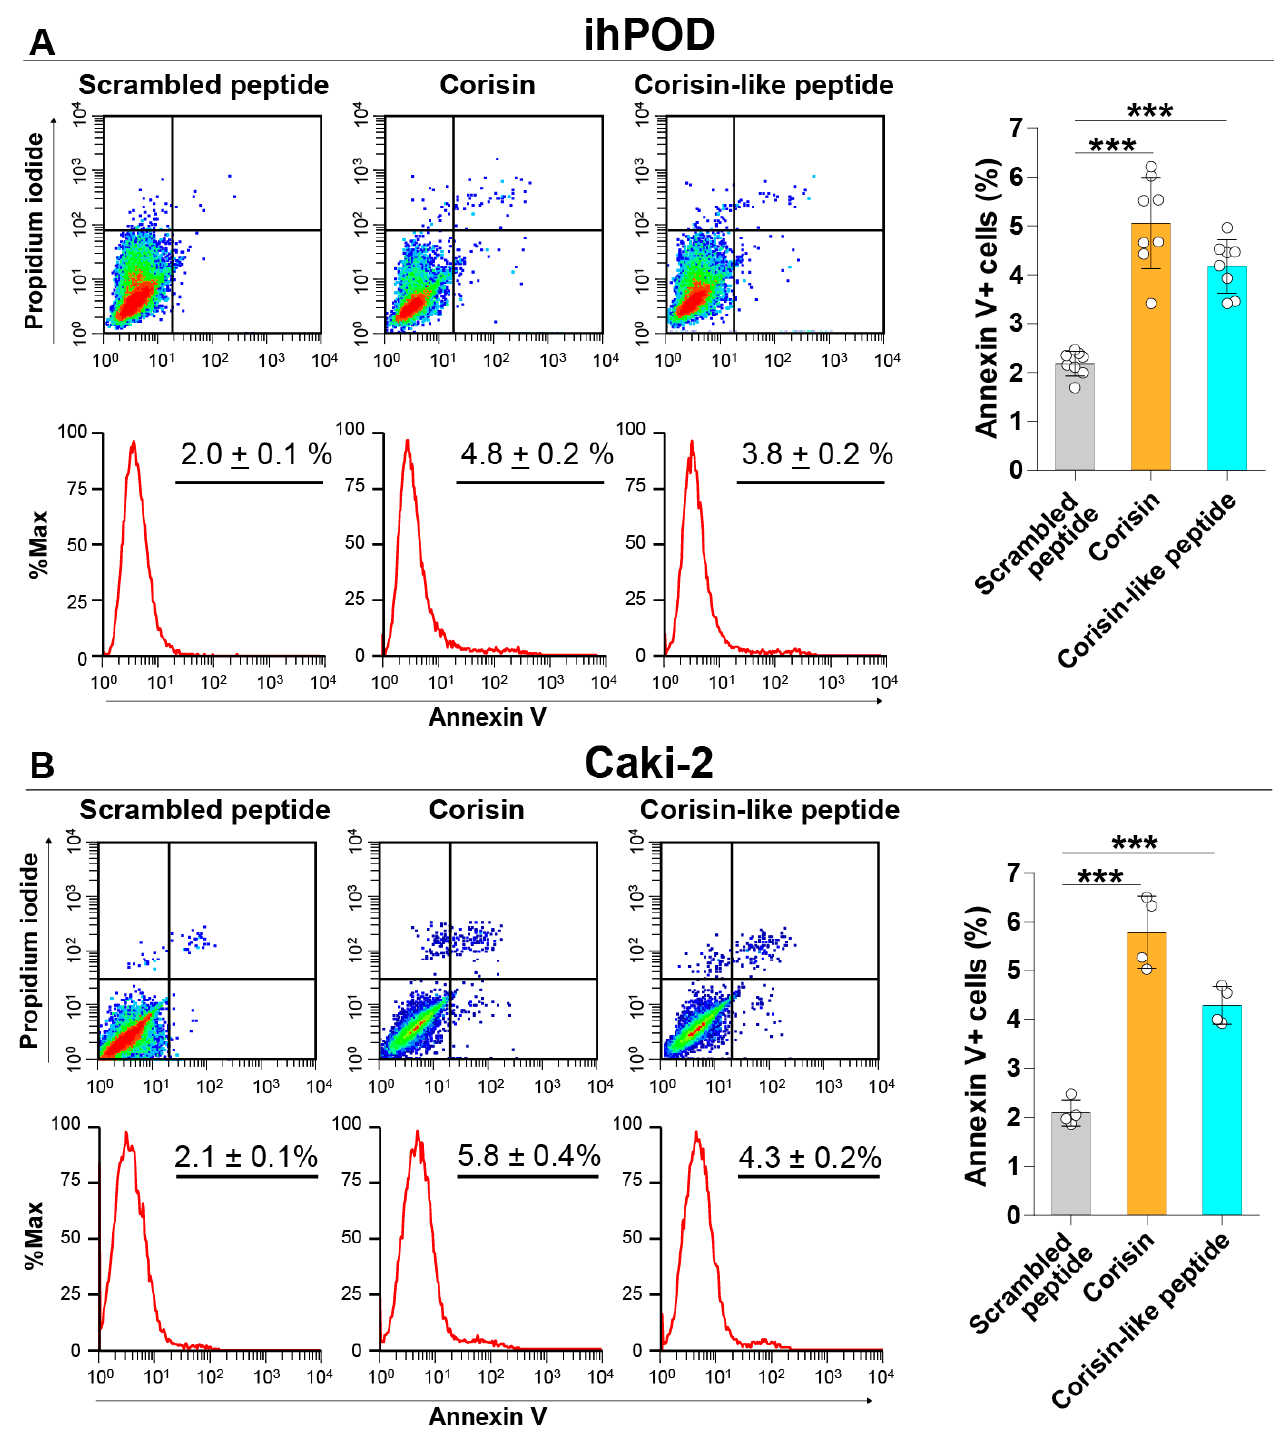
Figure 3. Corisin and corisin-like peptide induce apoptosis of podocytes and renal tubular epithelial cells. Podocytes ( A ) and Caki-2 cells ( B ) were cultured in the presence of corisin or corisin-like peptide for 48 h, and apoptosis was evaluated by flow cytometry. Data are expressed as the mean ± S.D. Statistical analysis by ANOVA with Newman-Keuls' test. *** p < 0.001.